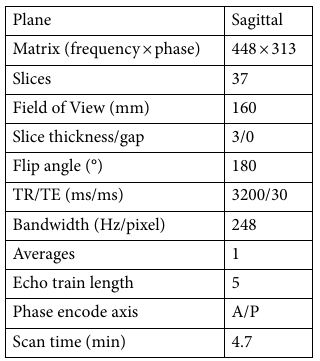
Table 1. Scan parameters for the sagittal TSE sequence used for effusion